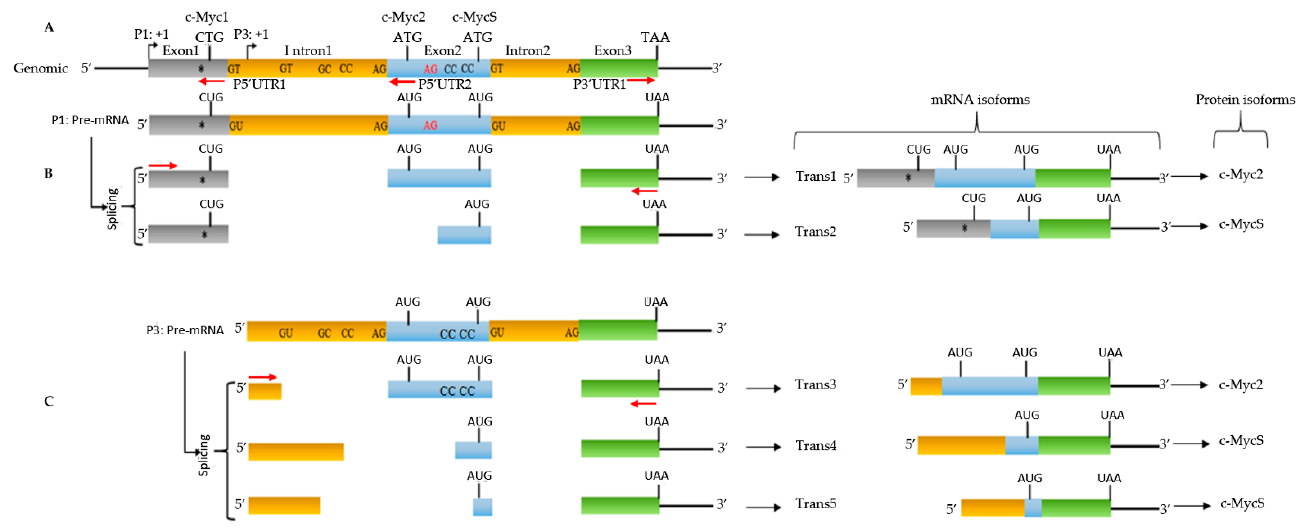
Figure 3. Different events leading to the genesis of several mRNAs of the c-MYC gene related to genomic structure. Genomic structure ( A ) at the origin of the different events ( B , C ). Primers P5’UTR1 and P5’UTR2 that were used to obtain the 5’UTR; primer P3’UTR1 to obtain the 3’UTR, and the other primers were used as indicated to obtain the full-length cDNA. The dinucleotides indicated represent the different splice donor and acceptor sites. The triplets indicate the translation initiation codons to obtain c-Myc1, c-Myc2, or c-MycS. TAA: Translation stop codon. *: PvuII mutation. Diagram is not to scale.